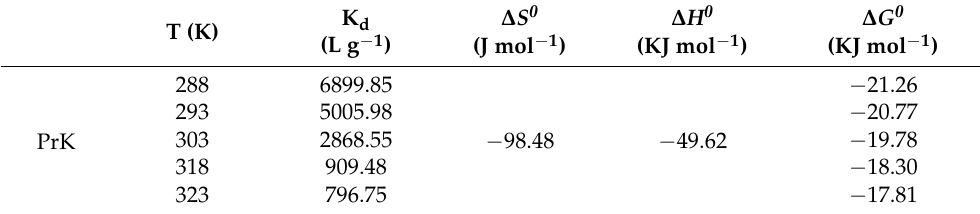
Table 1. Thermodynamic parameters for PrK adsorption by Co 4